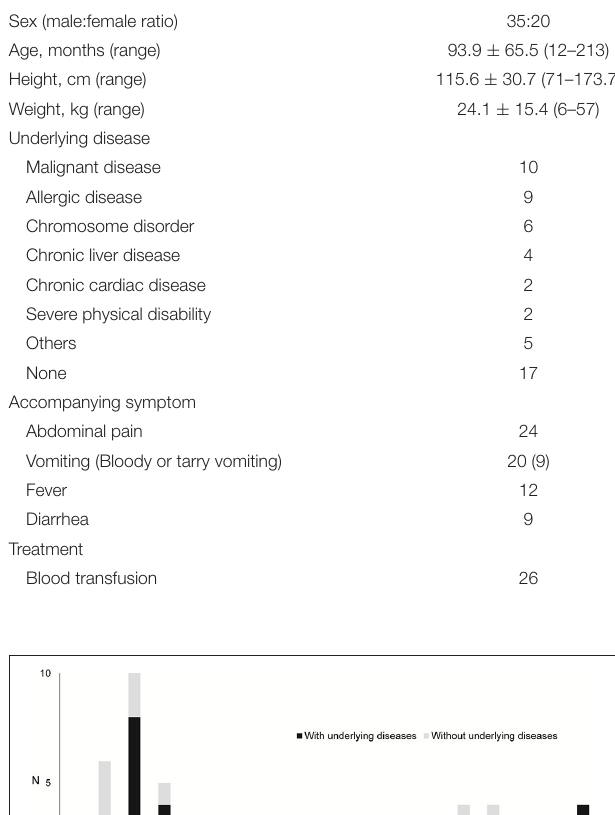
TABLE 1 | Characteristics of patients.